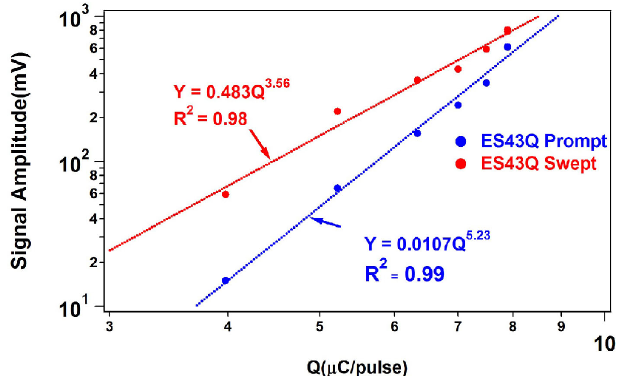
FIG. 9. (Color) Variation with beam intensity of prompt and swept signals from the quadrupole diagnostic (ES43Q) ( 9 = 16 = 06 ).